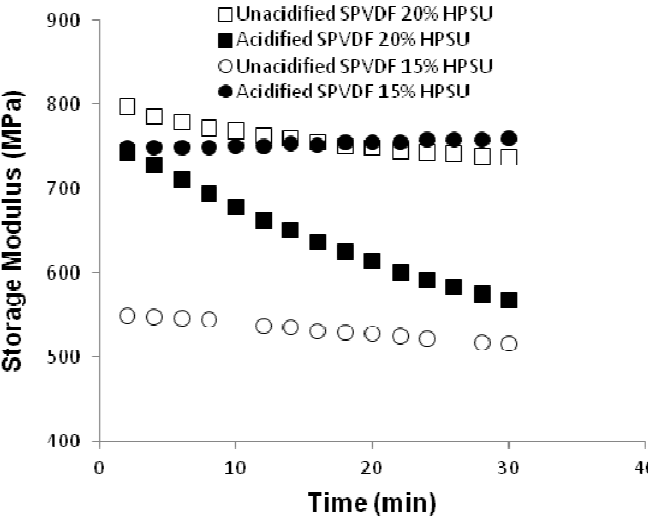
Figure 10. Storage moduli change of different blends at a constant humidity of 50%.